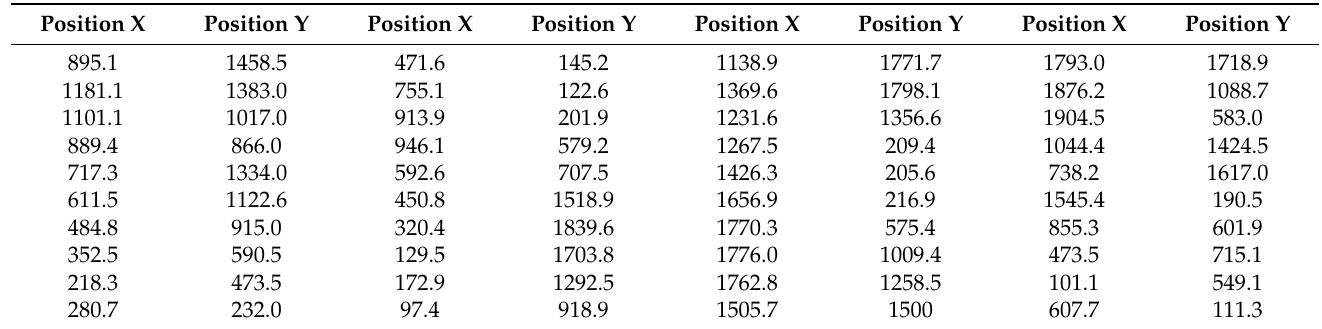
Table 3. Static target position.